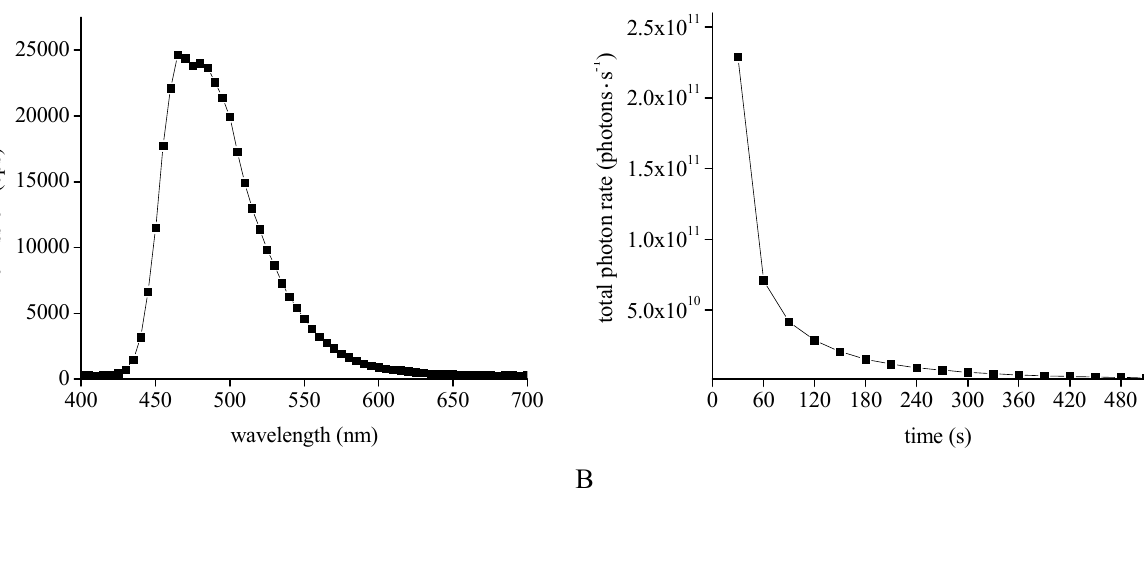
Figure 7. Optical properties of overexpressed Gaussia princeps luciferase: Gaussia princeps luciferase was overexpressed in a bacterial expression system after induction with IPTG and purified using affinity chromatography. Analysis of the emission spectrum displays the maximum intensity at 465 nm ( A ). Determination of total photon emission rate was performed in an IVIS-100 imaging system over a time period of 510 s ( B